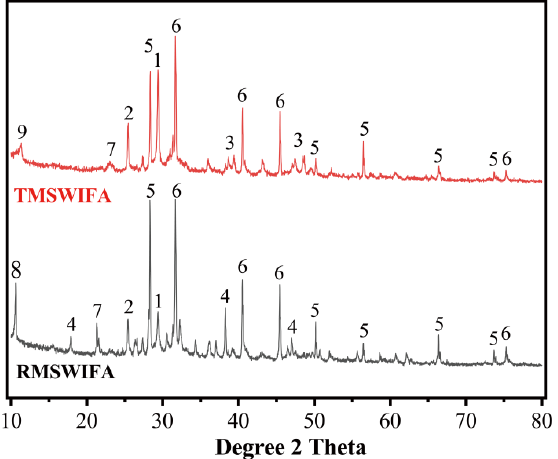
Figure 6. XRD patterns of RMSWIFA and TMSWIFA (1-CaCO 3 (PDF#72-1653), 2-CaSO 4 (PDF#37- 0184), 3-CaSO 4 ·H 2 O (PDF#39-0725), 4-CaClOH (PDF#73-1885), 5-KCl (PDF#75-0298), 6-NaCl (PDF#88-2300), 7-SiO 2 (PDF#79-1906), 8-CaAl 2 Si7O 18 ·1.7H 2 O (PDF#21-0132), 9-CaAl 2 Si 7 O 18 ·3.5H 2 O (PDF#24-0765)).